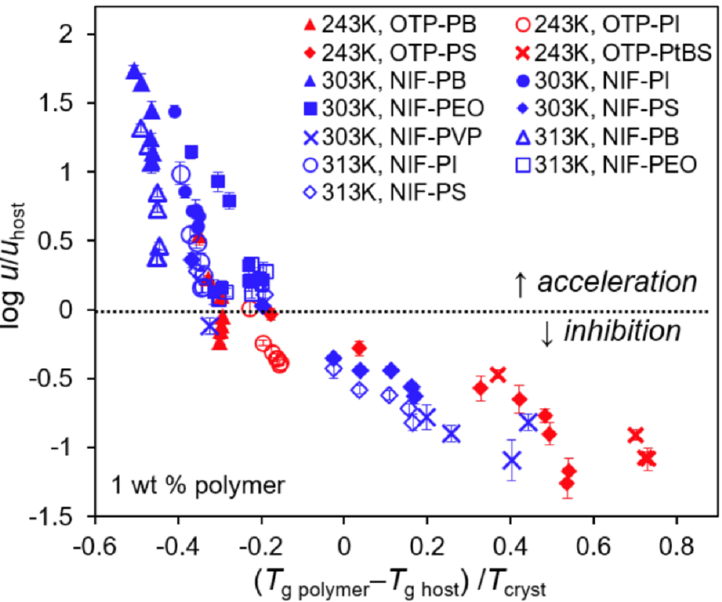
Figure 3. A master curve of polymer effects on crystal growth as a function of ( T g,polymer − T g,host ) / T cryst ). Here, the selected model compounds are o-terphenyl (OTP) and nifedipine (NIF). The selected polymers are polybutadiene (PB), polyisoprene (PI), poly(ethylene oxide) (PEO), polystyrene (PS), poly( tert -butylstyrene) (PtBS), and polyvinylpyrrolidone (PVP), with various molecular weights. Adapted from Ref. [14] with permission. Copyright © 2017 American Chemical Society.